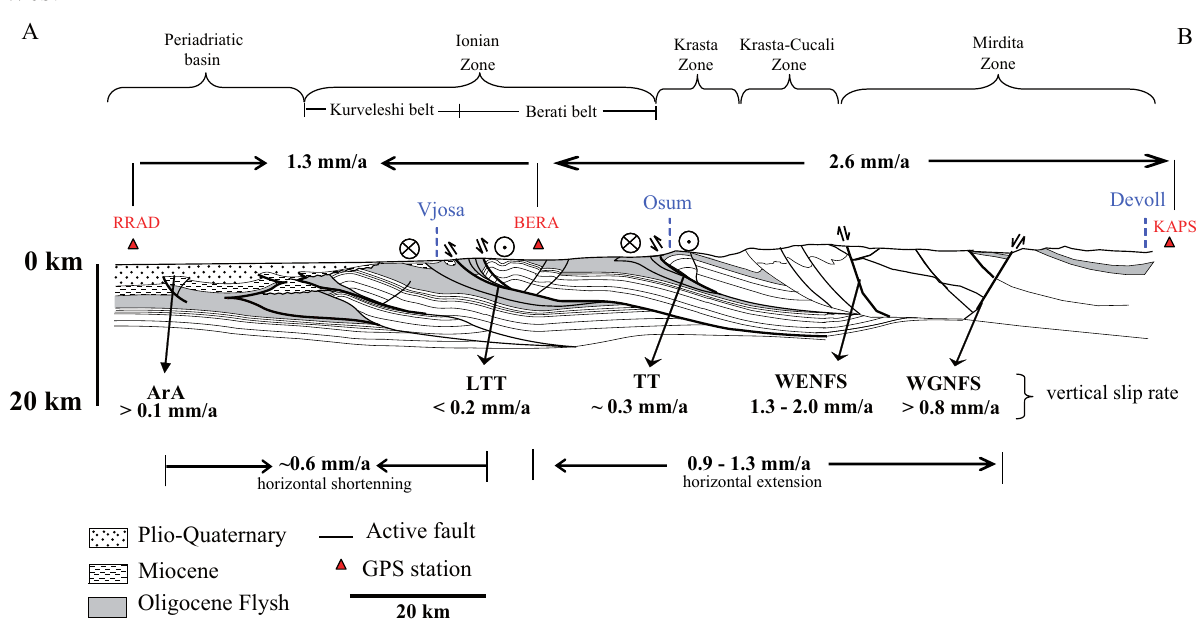
Figure 14. Simplified structural cross-section through the southern Albanides adapted from, the Geological Map of Albania [SHGJSH 2003], Kilias et al. [2001], Roure et al. [2004] and Carcaillet et al. [2009]. The neotectonic framework is modified from Aliaj et al. [1996, 2000] and the strike-slip component deduced from GPS network [Jouanne et al. 2012]. Values of relative displacements between GPS sites are indicated above GPS stations. Vertical slip rates calculated in the present study are shown, as well as, the horizontal shortening and extension estimated from the slip rate.